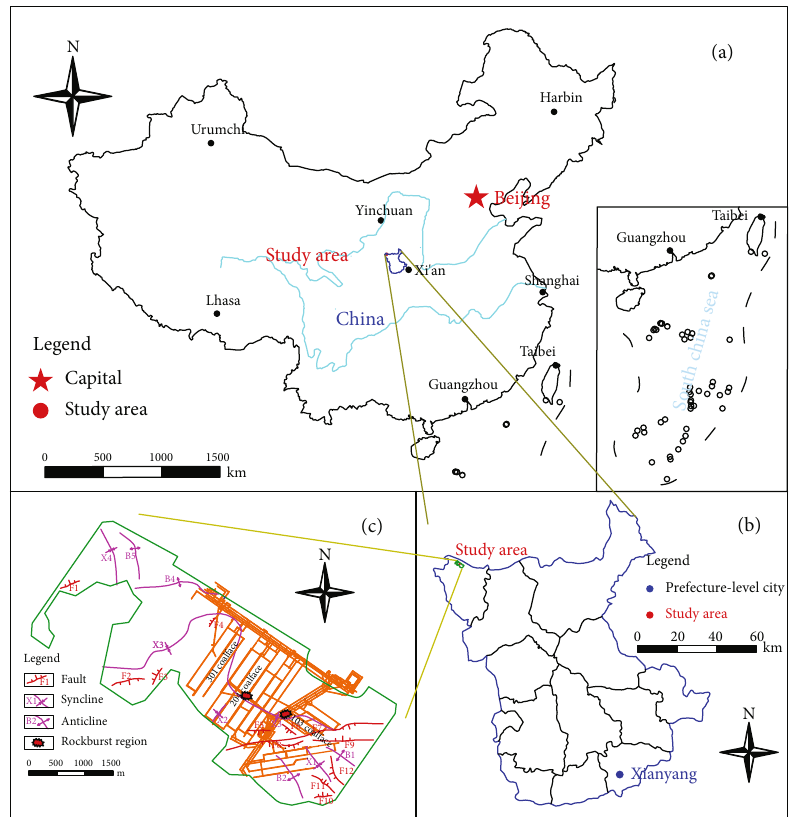
Figure 1: Geographical location and rockburst regions distribution of the study